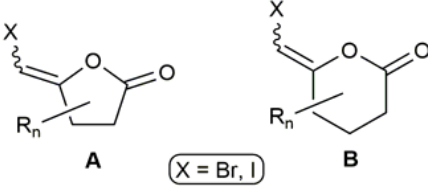
Figure 2. Generic structures of haloenol lactones featuring biological activity.